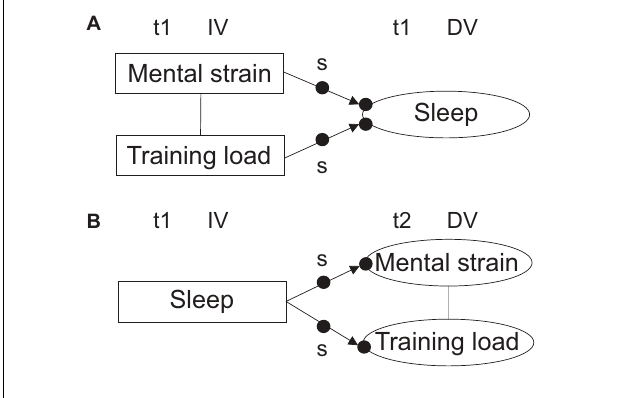
FIGURE 2 | A visual representation of the primary aims in the current study, with investigation of the effects of mental strain and training load on sleep (A) , and of sleep on next day mental strain and next day training load (B) . Filled, unmarked circles represent random intercepts. Filled circles marked ‘s’ represent random slopes. The figure specifies temporal relationships between the variables, as well as dependent and independent variables.